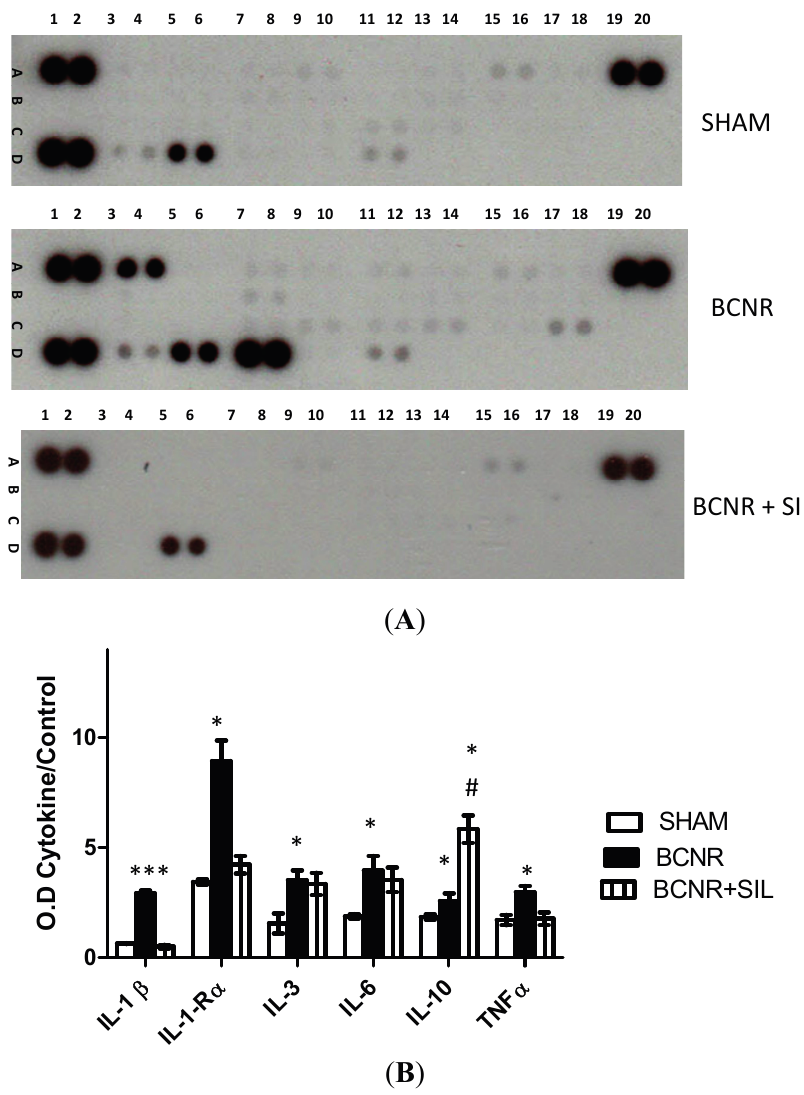
Figure 1. Cytokine expression is regulated by BCNR and SIL treatment. Protein extracts were incubated with a cocktail of biotinylated detection antibodies and then incubated in a membrane array containing 29 different anti-cytokine antibodies, in duplicates, followed by streptavidin peroxidase and chemoluminescence. The densitometric signal produced by each spot run in duplicate was proportional to the amount of cytokine bound as determined by densitometry analysis. ( A ) Representative membranes for Sham, BCNR and BCNR + SIL; ( B ) Densitometry analysis of cytokines * p < 0.05; *** p < 0.001 with respect to sham. # p < 0.05 with respect to